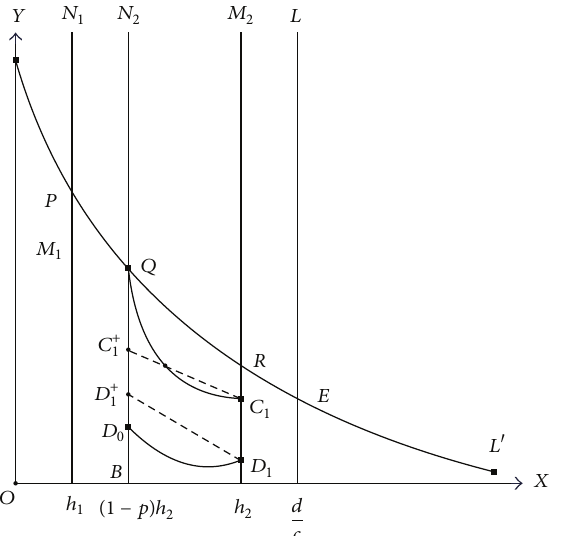
Figure 11: The orbit starting from the point 𝐶 0 (Case 1(b) in Section 4.1.3).